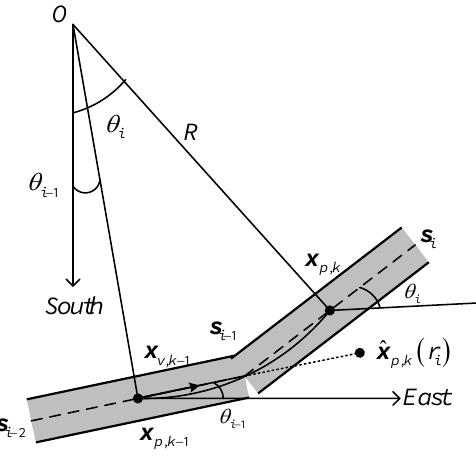
Figure 3. Schematic diagram of a curved road in a digital roadmap.